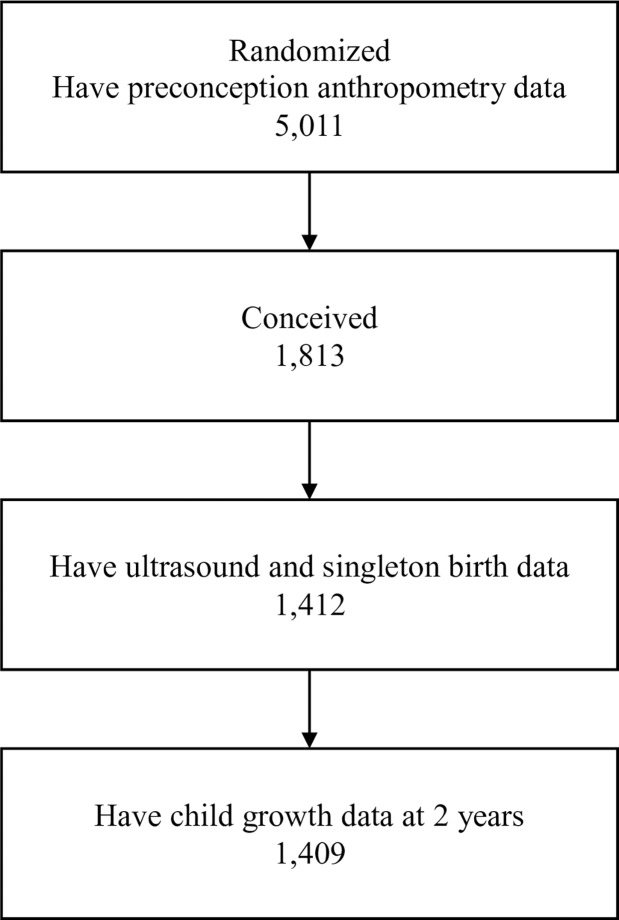
Flow diagram of participant progress throughout the study.Flow diagram of participant enrollment and follow-up of mother-child pairs.